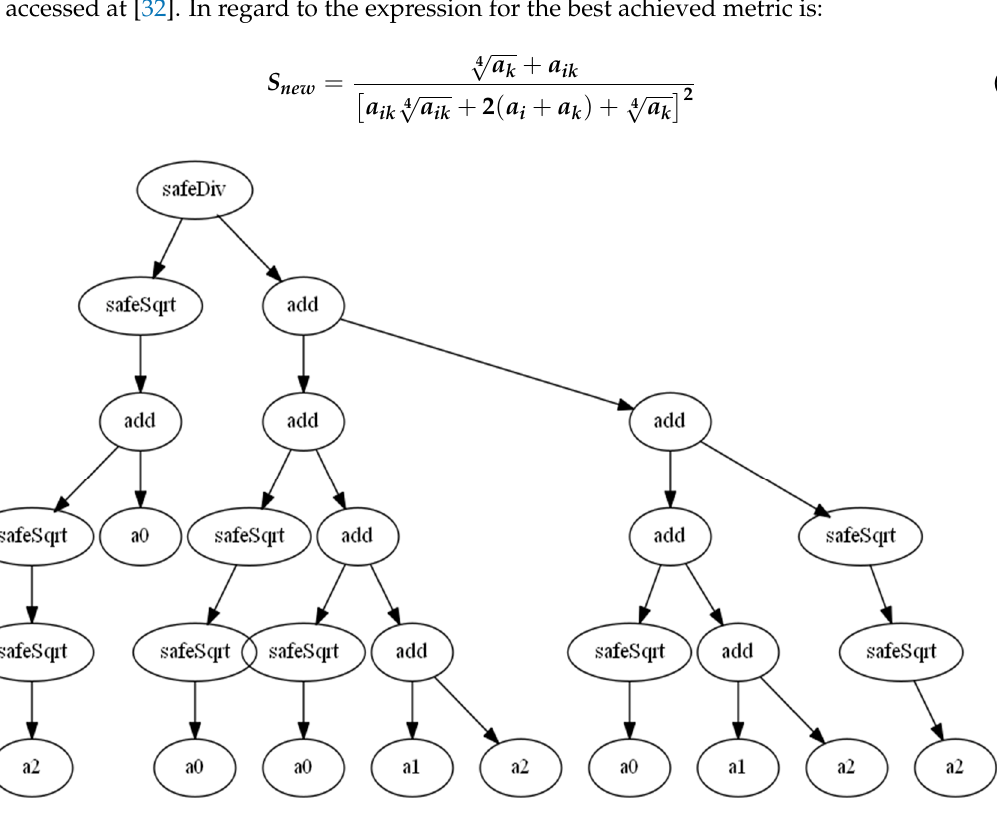
0 = a ik , a 1 = a i , and a 2 = a k